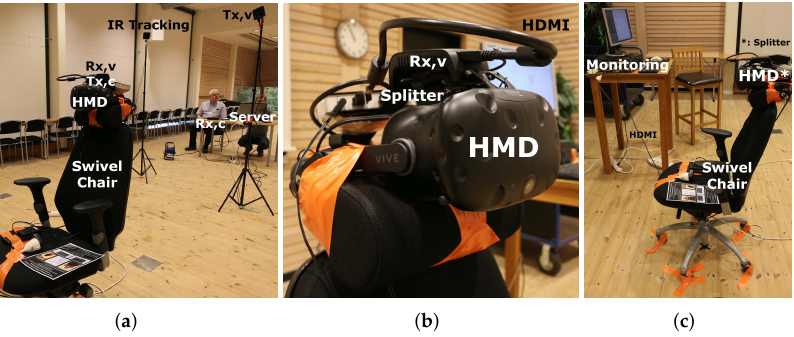
Figure 4. Hardware components of the TPCAST wireless VR testbed: ( a ) Transmitter and IR tracking (top) and server along with operators (right), ( b ) HMD holding the TPCAST receiver and splitter mounted on the full-swivel chair, ( c ) Monitoring equipment (top) and full-swivel chair placement